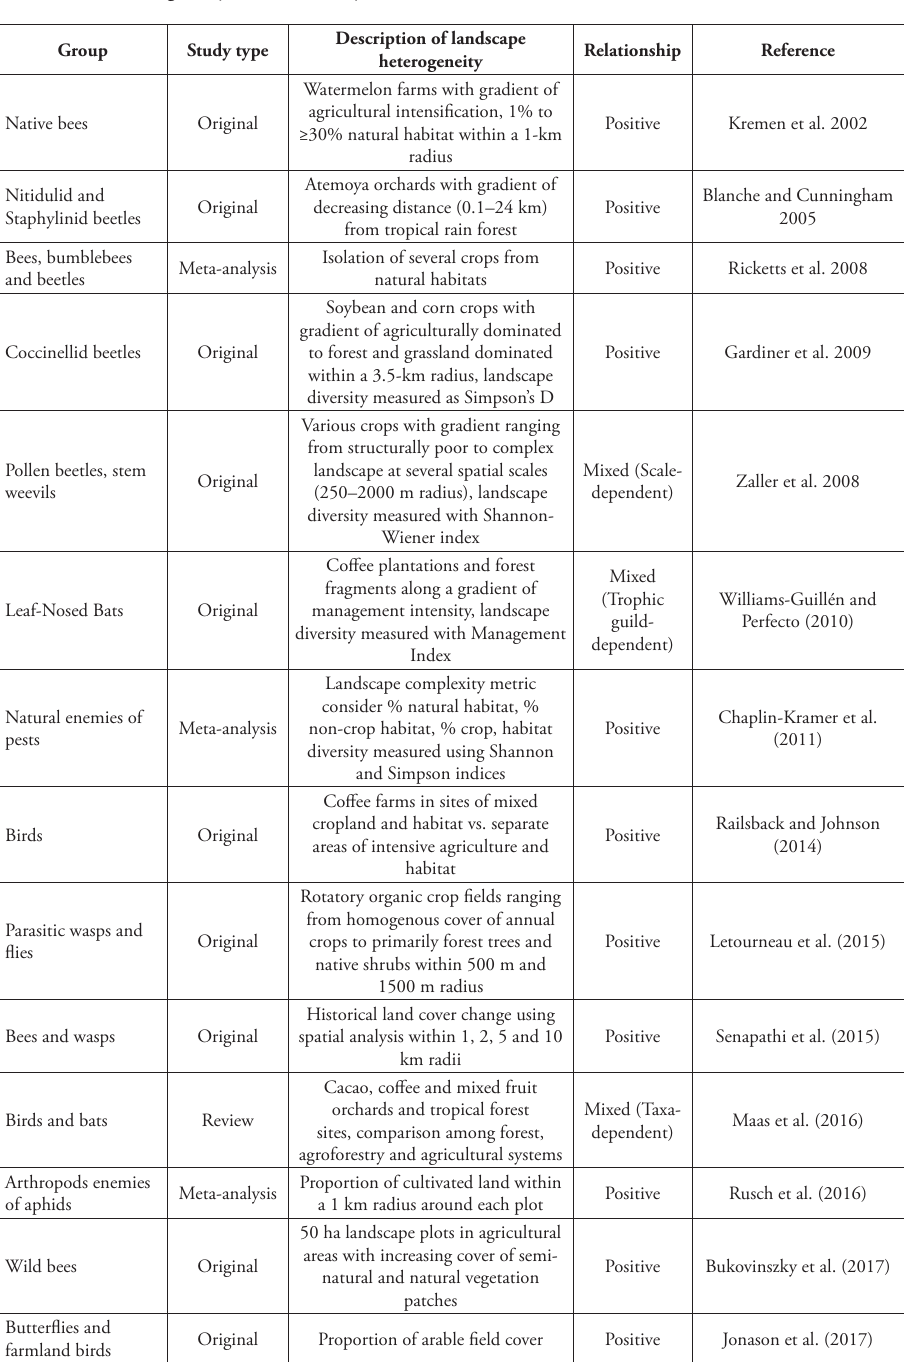
Table 3. Faunal ecosystem service providers and landscape heterogeneity. Examples of studies evaluating the relationship of landscape heterogeneity and FES providers richness and abundance, including the definition of heterogeneity as described by the studies’